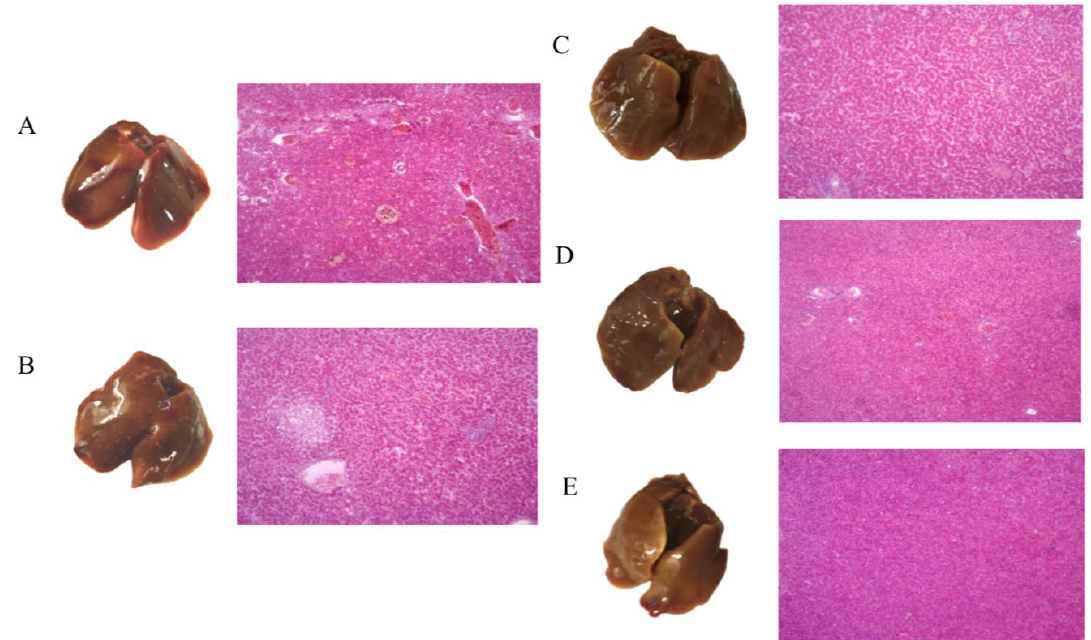
Figure 6. Histopathologic H&E assessment of liver and tissue samples (100×). ( A ) Control group, ( B ) pPICZ group, ( C ) Phage group, ( D ) LySP2 group, ( E ) Normal group.